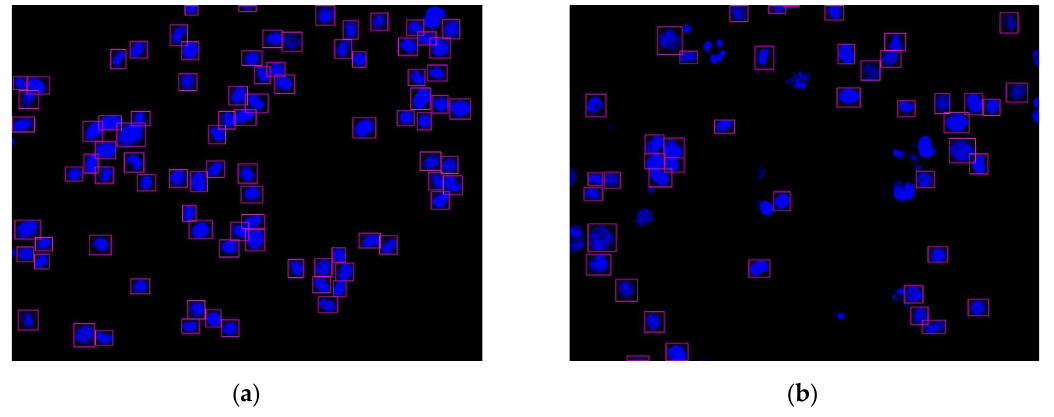
Figure 12. Two nucleus images recognized by the YOLO algorithm: ( a ) HCT116 cell with DMSO (no.4484); ( b ) HCT116 cell with dinaciclib (no.4496).